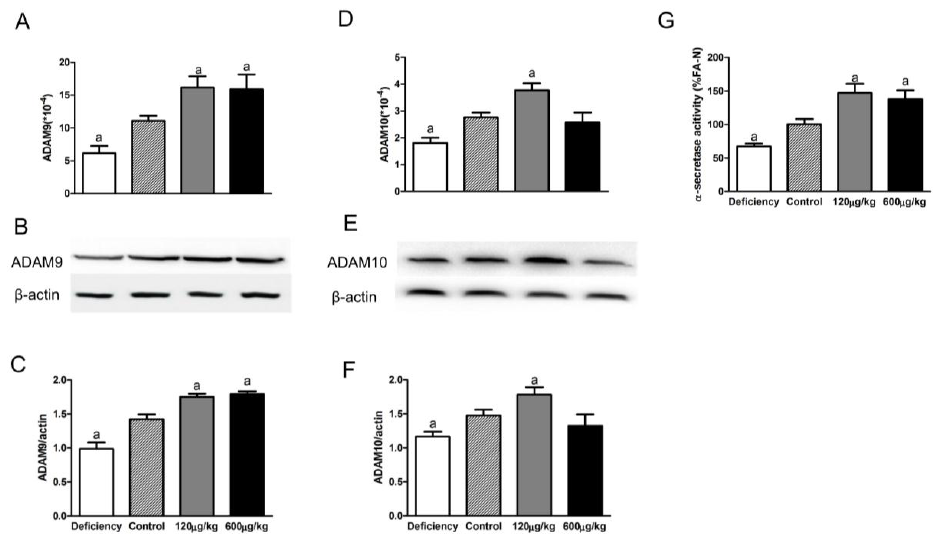
Figure 2. Folate stimulated ADAM9 and ADAM10 expression in APP/PS1 mice. The mRNA/protein levels of ADAM9 and ADAM10 in the brains of APP/PS1 mice were detected by qRT-PCR/Western blot analysis. Representative immunoblotting images of ADAM9 and ADAM10 are shown. Quantitative analysis revealed that the 120 µ g/kg folic acid treatment led to up-regulation of ADAM9 ( A – C ) and ADAM10 ( D – F ). Folate deficiency led to down-regulation of ADAM9 and ADAM10. The 600 µ g/kg folic acid treatment only up-regulated ADAM9, but did not change ADAM10 level; total α -secretase activity was reduced in the deficiency group and was increased in both 120 µ g/kg and 600 µ g/kg groups ( G ). The data were expressed as means ± SD values, n = 6 animals/group. a: p < 0.05 versus the control group.